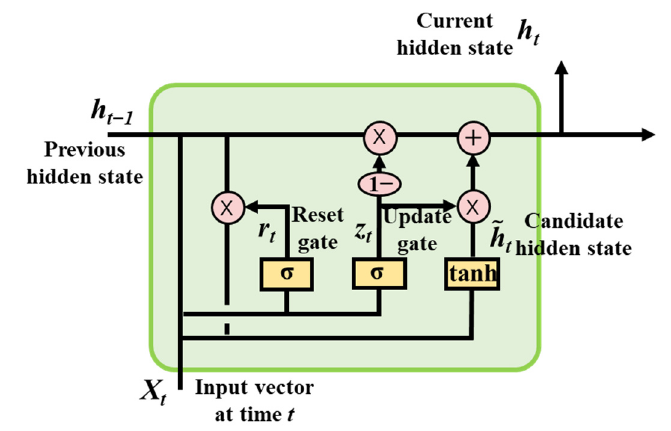
Figure 2. The schematic of GRU